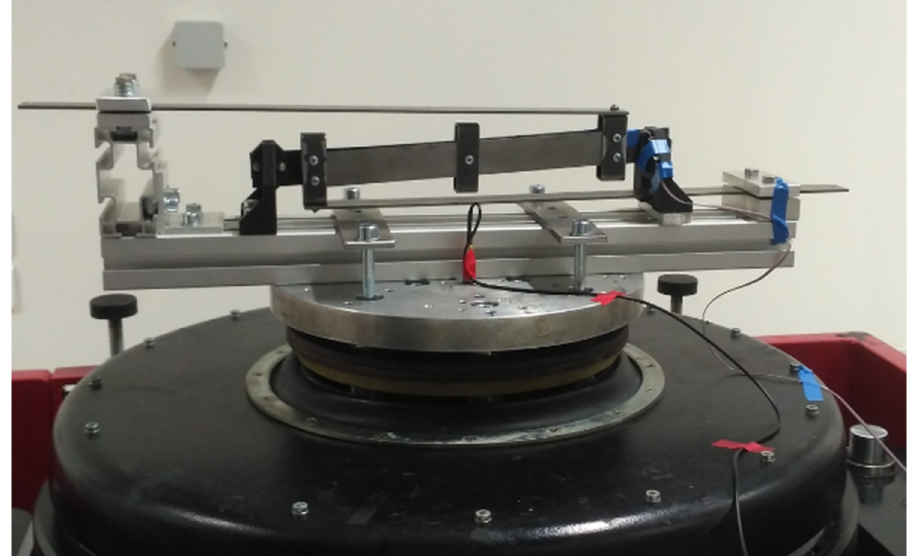
Figure 6. Shaker lab test of kinetic energy harvester.